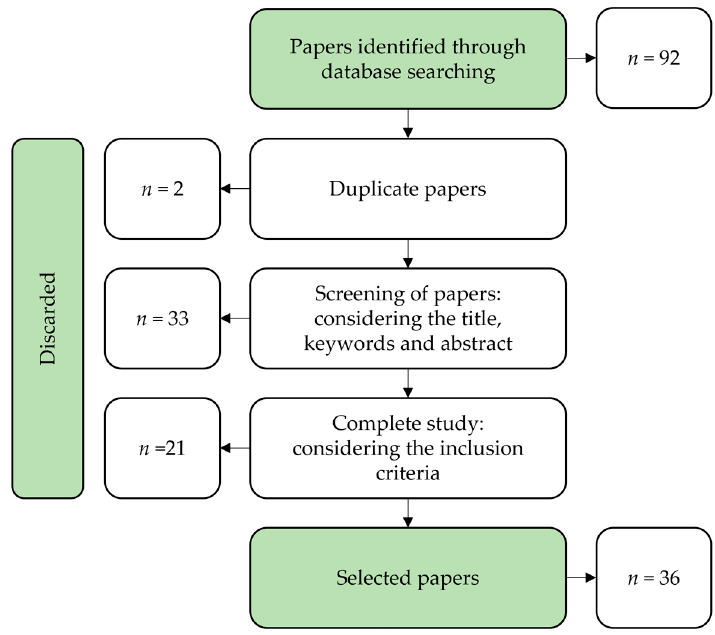
Figure 3. Flow diagram of the selection of the papers.